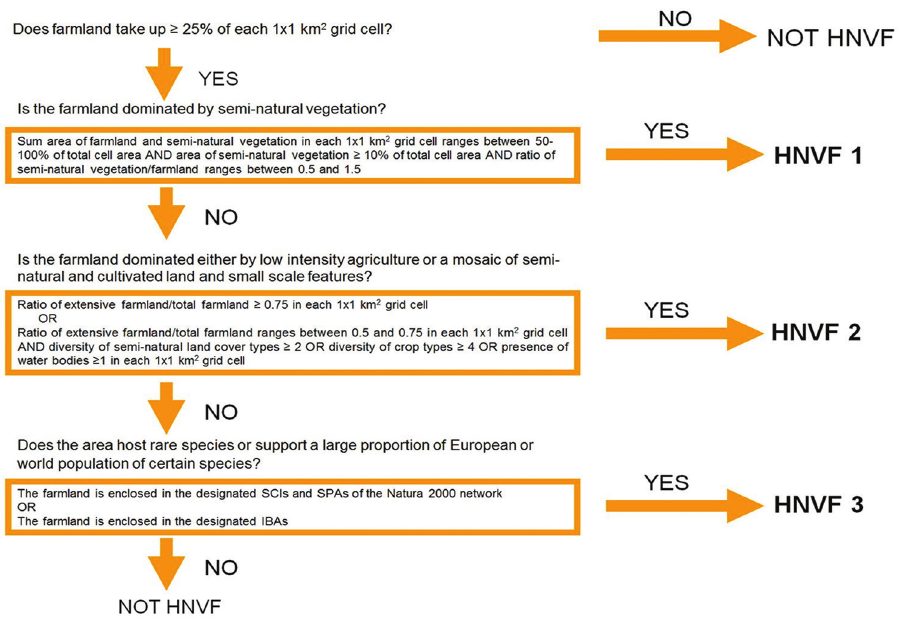
Figure 1. Selection rules for mapping the three types of potentially HNVfs in Cyprus using the conserva- tive storyline (25% threshold). The liberal storyline was applied with identical rules with the exception of the 10% threshold for % farmland within every 1 km 2 grid